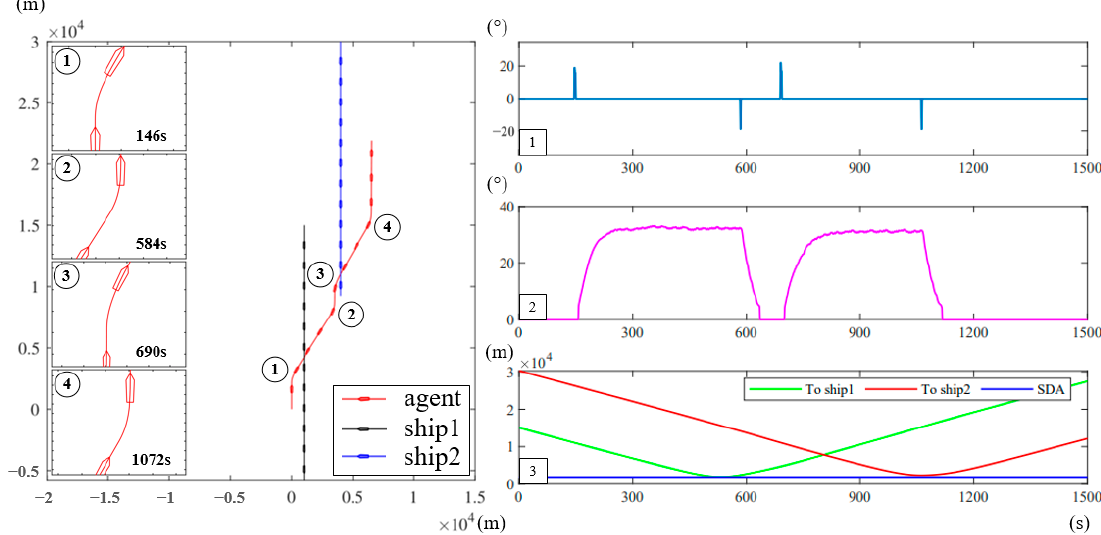
Table 3. Comparisons between different methods.